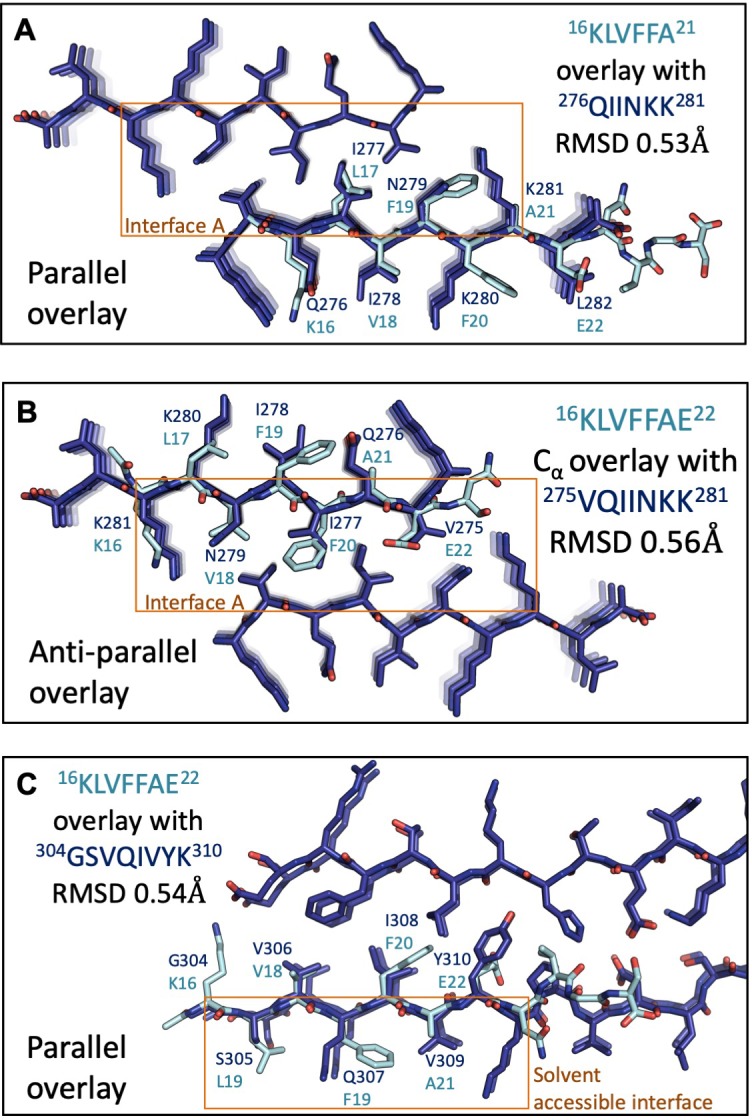
The spines of Aβ 16–26 D23N and tau are structurally similar.(A, B) Aβ 16–26 D23N overlay with tau 274–283 in parallel and antiparallel orientations. (A) 32 backbone atoms differ from each other by 0.53 Å RMSD. RMSD values were calculated using LSQ in Coot. (B) The Cα atoms differ from each other by 0.56 Å RMSD. Backbone and side chain rotamers were optimized with Foldit over 2000 iterations to minimize energy to −603 REU. (C) Aβ 16–22 overlay with tau 304–310 in parallel, backbone atoms differ from each other by 0.54 Å RMSD. RMSD values were calculated using LSQ in Coot.